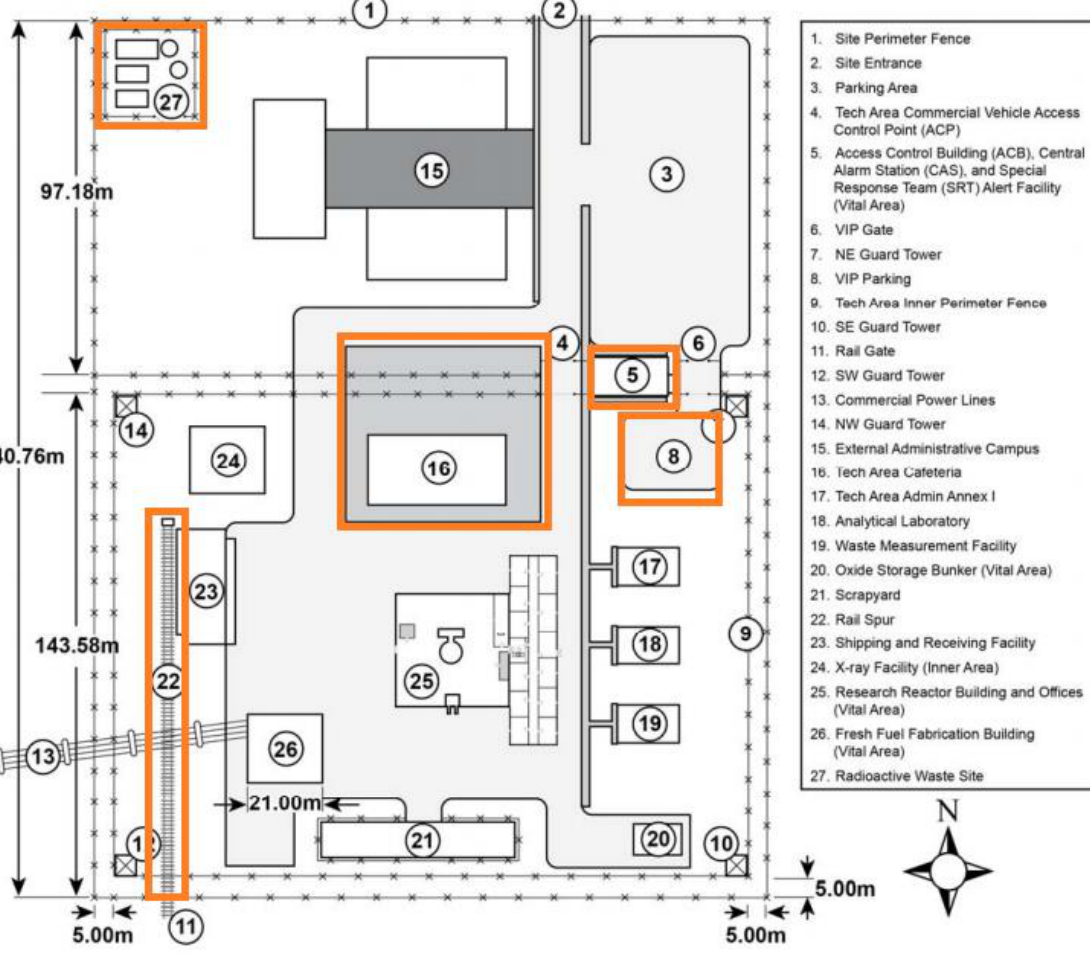
Figure 1: The Site Layout as Described in the Data